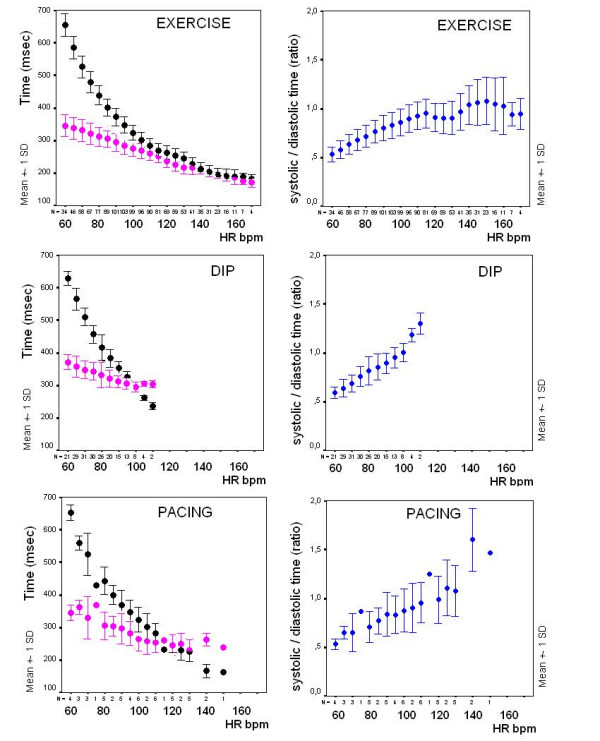
Summary data. Left panels: plot of systolic (pink symbols) and diastolic (black symbols) mean ± SD time values at increasing heart rates during exercise, dipyridamole and pacing stresses. Right panels: plot of systolic/diastolic time ratio as mean ± SD time values at increasing heart rates in the same patients groups; despite lower peak stress heart rates, dipyridamole patients show systolic/diastole time reversal at around 100 bpm heart rate.